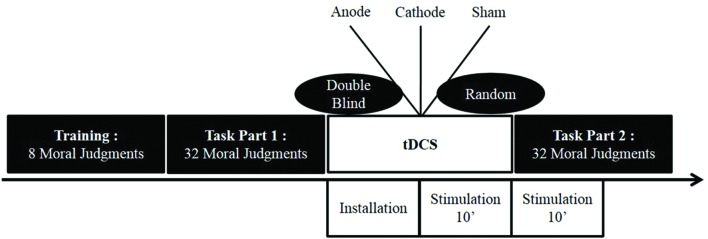
Illustration of the tDCS protocol used in Experiments 1 and 2.